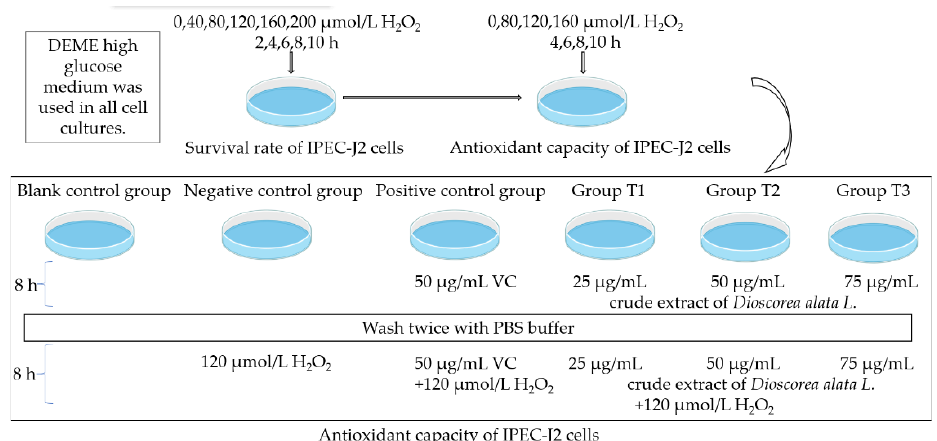
Figure 1. Experimental